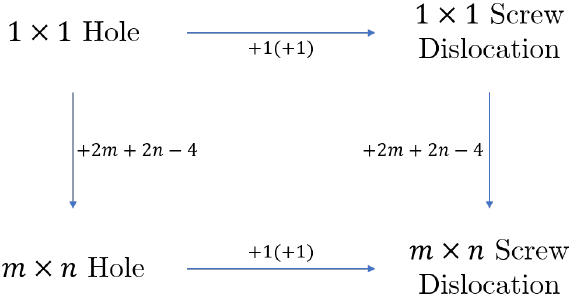
Figure 26: The scheme to create a large screw defect forms a commutative diagram. The horizontal lines add the dislocation about the hole and the vertical lines add half- leaves. The value on the arrows denote the change in log for matching defect and outer boundaries, with the additional (+ 1 ) for even L